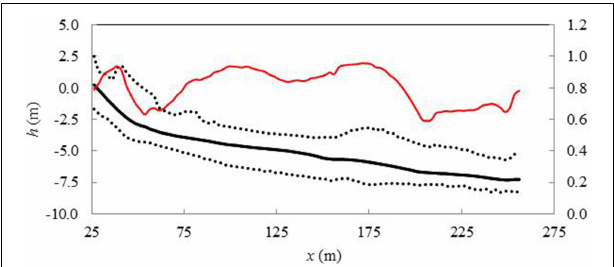
FIGURE 2 | Mean profile (dark black line), profile envelope (broken black lines) and standard deviation (red line) of measured profiles between 1987 and 2005 at Ogata Wave Observation Pier.